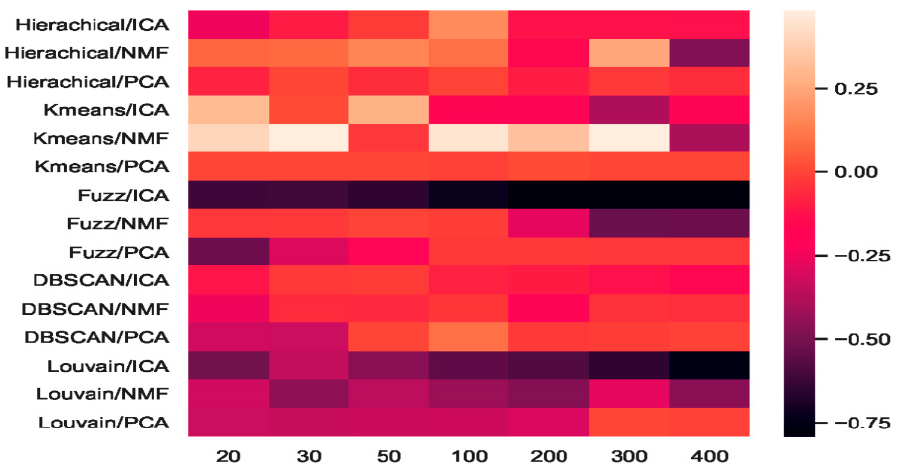
Figure 12. Heatmap of clustering accuracy improvement using feature extraction on 500 genes of the mouse visual cortex.